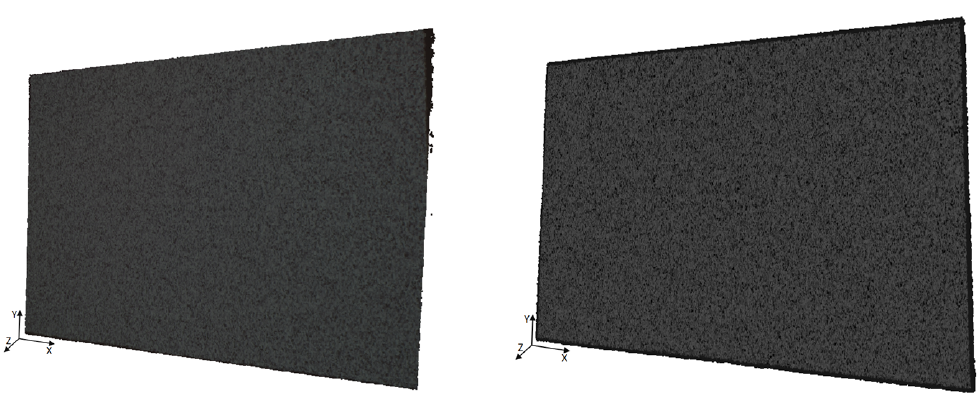
Figure 6. Dense point clouds generated by image data collected in ( left ) real and ( right ) virtual